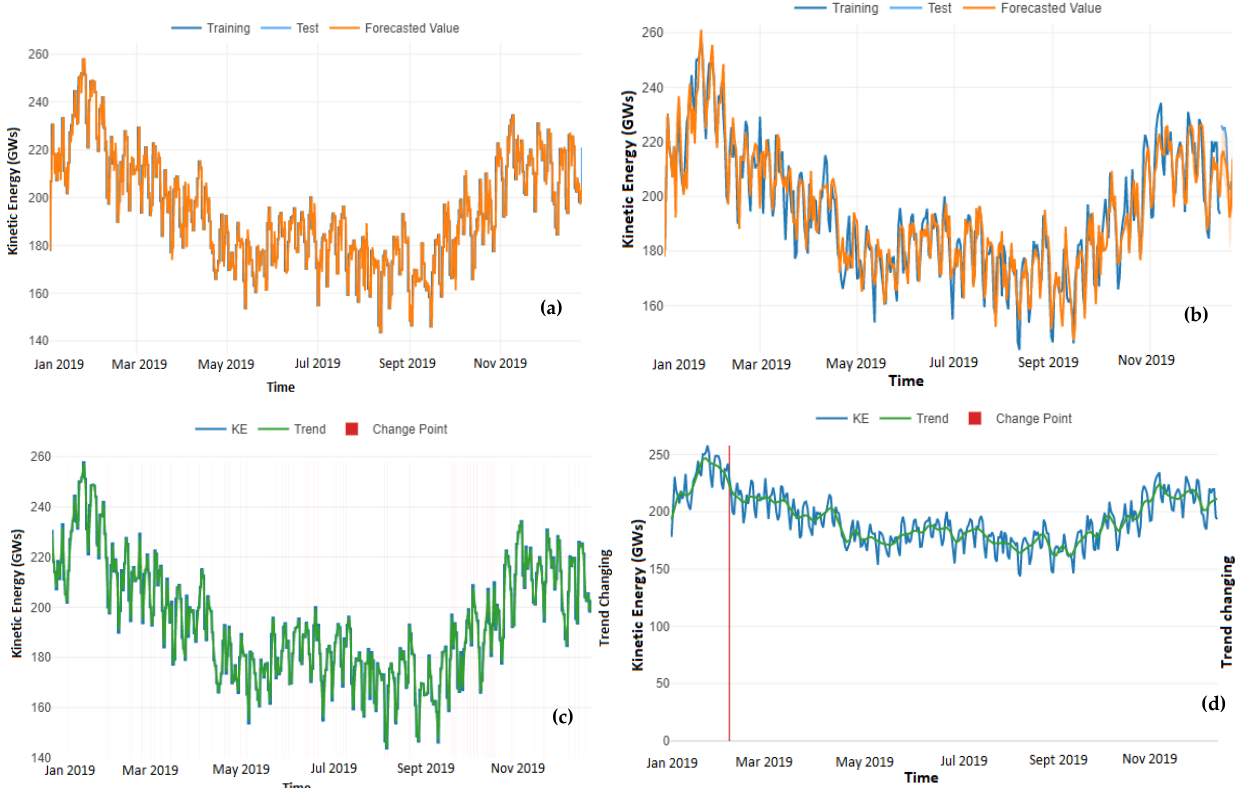
Figure 7. Results showing the nature of training, testing, and forecasted values by using ( a ) the Bayesian model and ( b ) ARIMA model. Similarly, ( c , d ) the trend and changing trend patterns for the Bayesian and ARIMA models are shown.